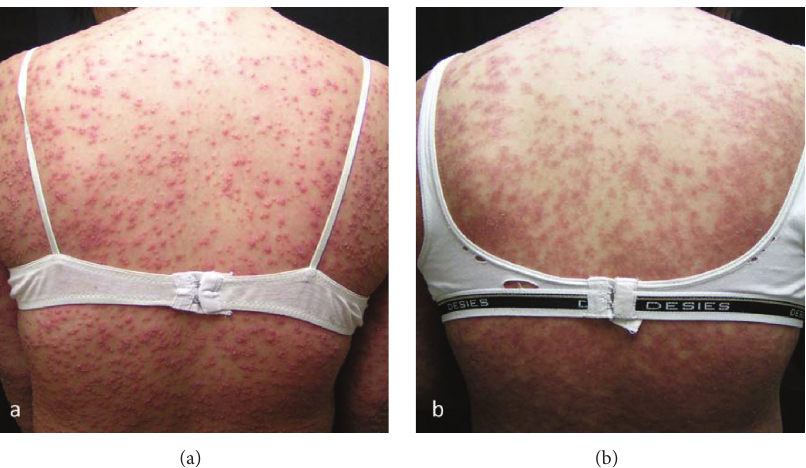
Figure 3: (a) Numerous small superficial pustules on erythematous base in a patient with AGEP. (b) Erythema and desquamation 3 days after discontinuation of culprit drug, and administration of systemic corticosteroid.